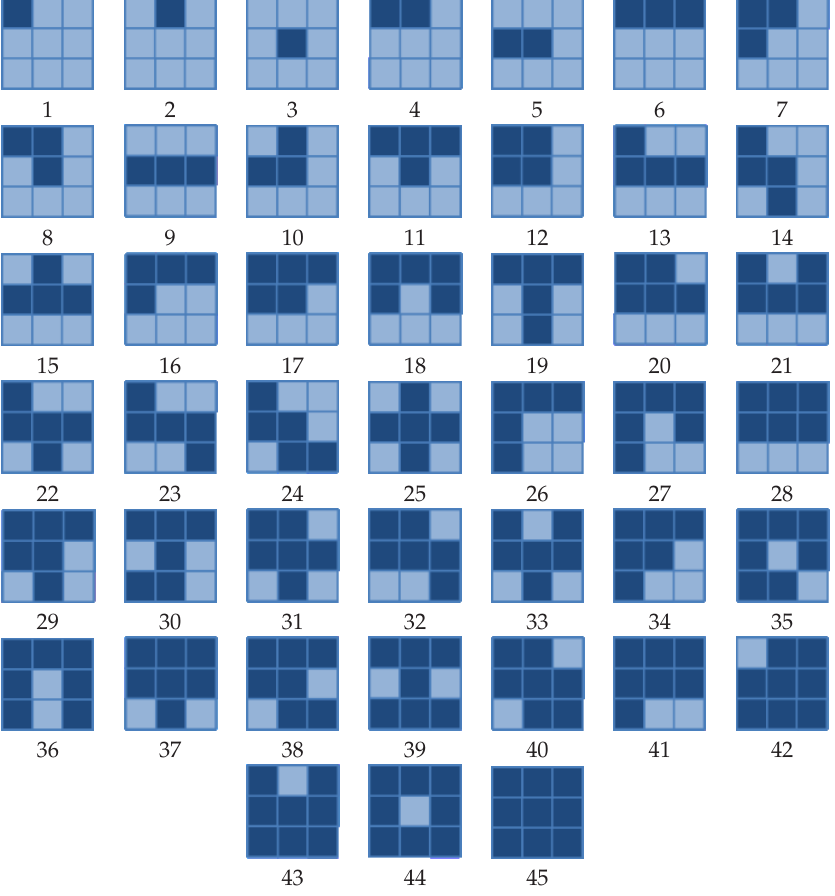
Table 1: Exemplars for each direction relation matrix class (reference for Table